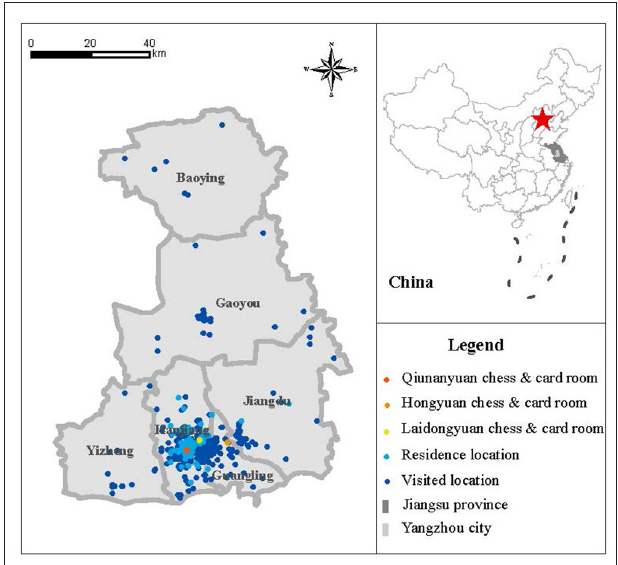
FIGURE 1 | The residence location and visited location of confirmed cases (Yangzhou, China, 2021).